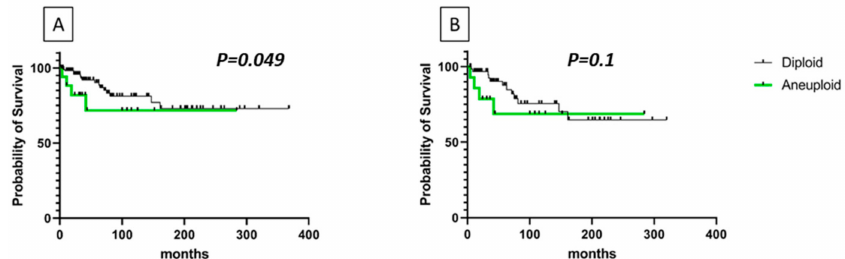
Figure 6. Survival curves of diploid or aneuploid RET MTC patients. ( A ) patients with an altered number of RET copies showed a significantly ( p = 0.049, by Gehan-Breslow-Wilcoxon test) lower survival. ( B ) RET positive patients with a RET gene CNV showed a lower survival with respect to RET positive patients with a diploid status ( p =